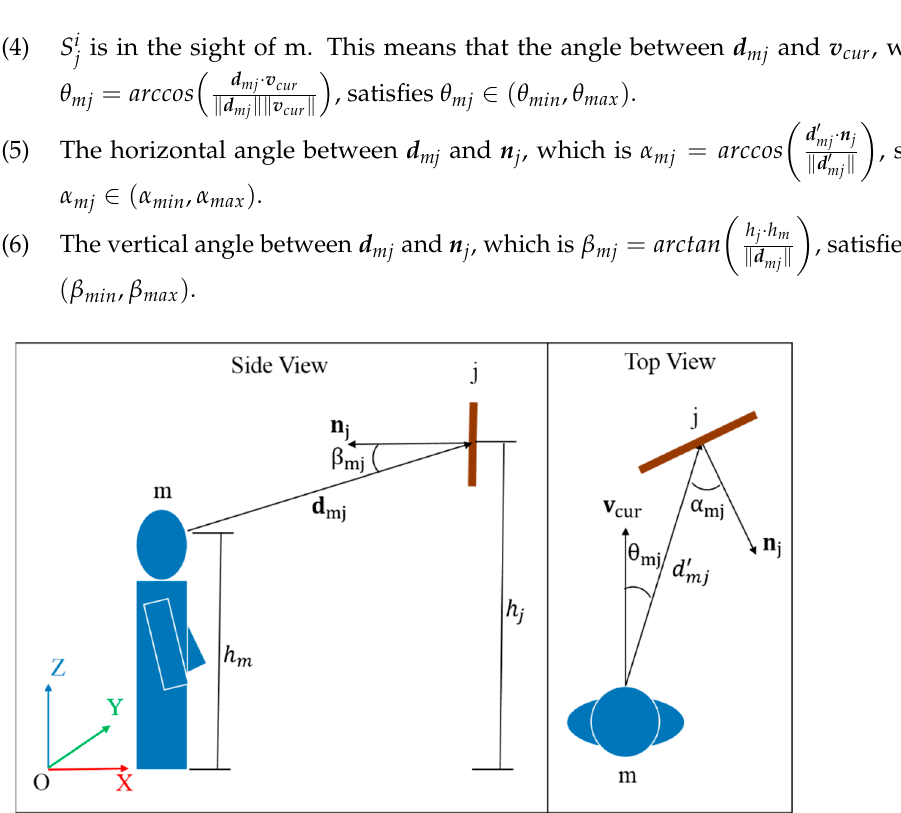
Figure 8. Schematic diagram of perception.